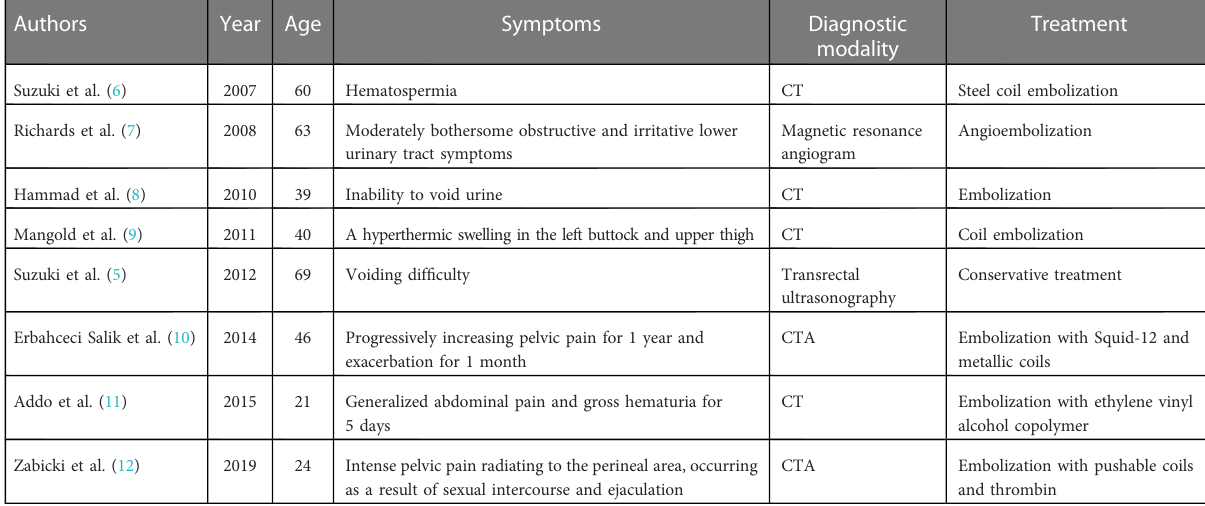
TABLE 1 Synopsis of the presenting symptoms, diagnostic modalities, and therapeutic strategies of the eight congenital pelvic arteriovenous malformations developed in male patients.